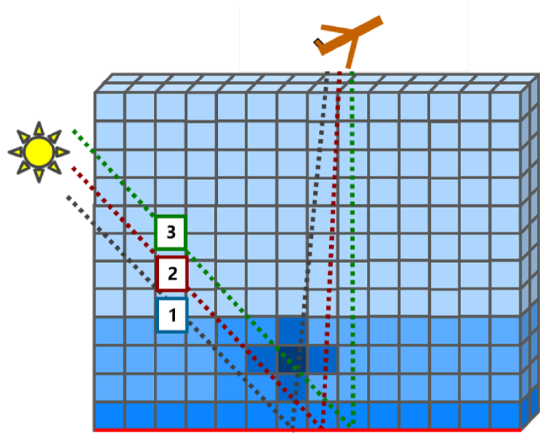
Figure 9. Schematic of the across-track measurement by the aircraft measuring a NO 2 plume (dark blue corresponding to high NO 2 con- centrations) with three main photon paths for three measurement geometries (1, 2,